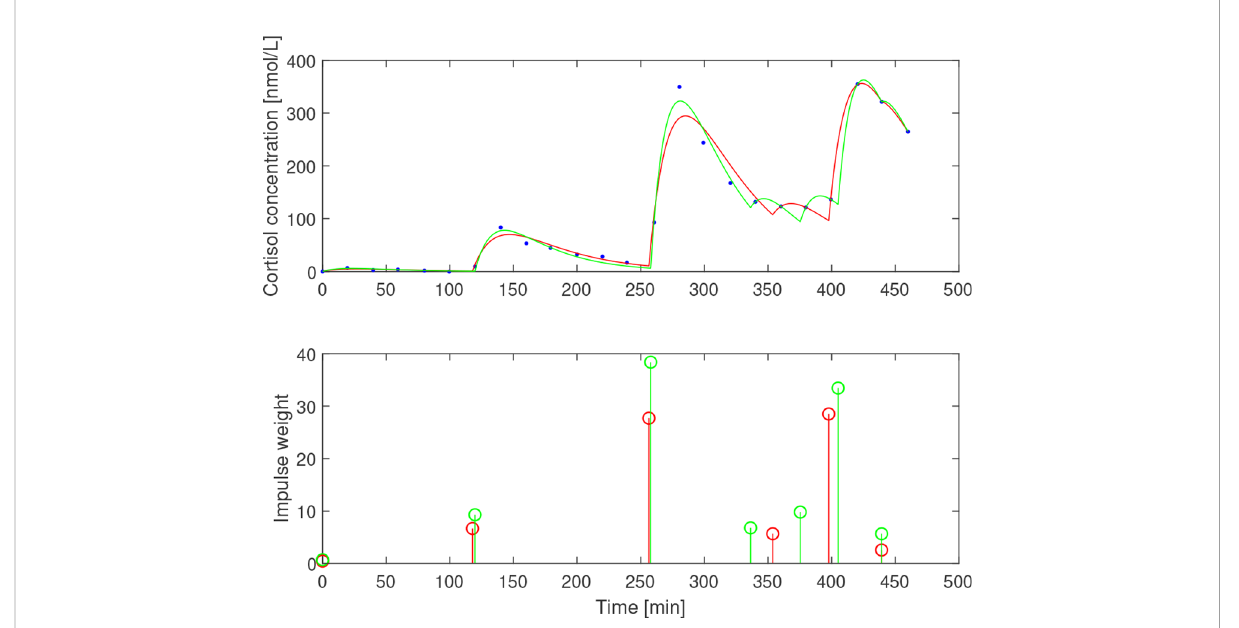
FIGURE 12 Simulated cortisol concentration (top) together with measured values (blue dots) and impulse estimates (bottom) from estimation assuming b